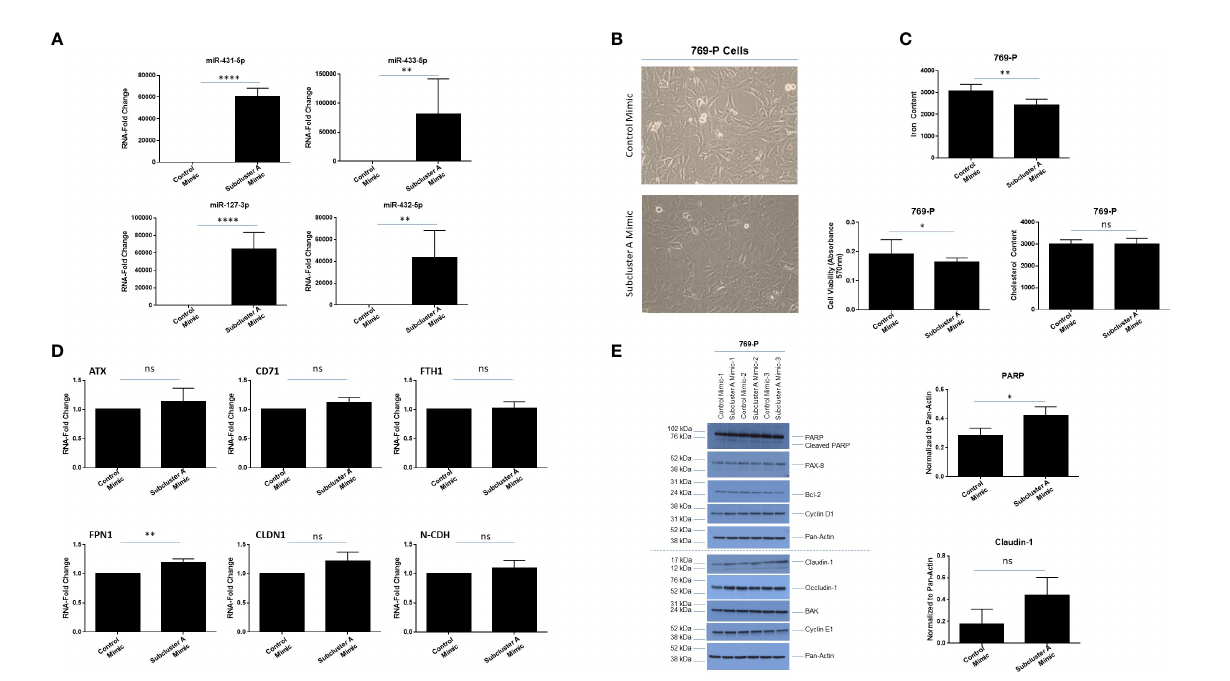
FIGURE 8 Subcluster A mimic transfection modulates labile iron content and claudin-1 expression in 769-P cells. (A) qPCR analyses of miR-431-5p, miR-433- 5p, miR-127-3p, and miR-432-5p, and RNU48 in 769-P cells. (B) Representative microscopic images of 769-P cells at 48 hours post-transfection with either control mimic or subcluster A mimic at 20x magni fi cation. (C) Measurement of the labile iron content (top panel), cell viability via crystal violet (bottom left panel), and cholesterol content (bottom right panel) following miRNA transfection in 769-P cells at 48 hours. The composite of three independent experiments is shown. (D) qPCR analyses of ATX , CD71 , FTH1 , FPN1 , CLDN1 , and N-CDH are shown, normalized to PP1A . The data represents composite of three independent experiments. (E) Protein lysates were obtained from control or subcluster A mimic transfected 769- P cells at 48 hours post-transfection. Western blotting using the antibodies shown was then performed. Densitometric analyses for PARP and claudin-1 are shown in the right panels. ns, not signi fi cant; * p -values ≤ 0.05;** p -values ≤ 0.01; **** p -values ≤